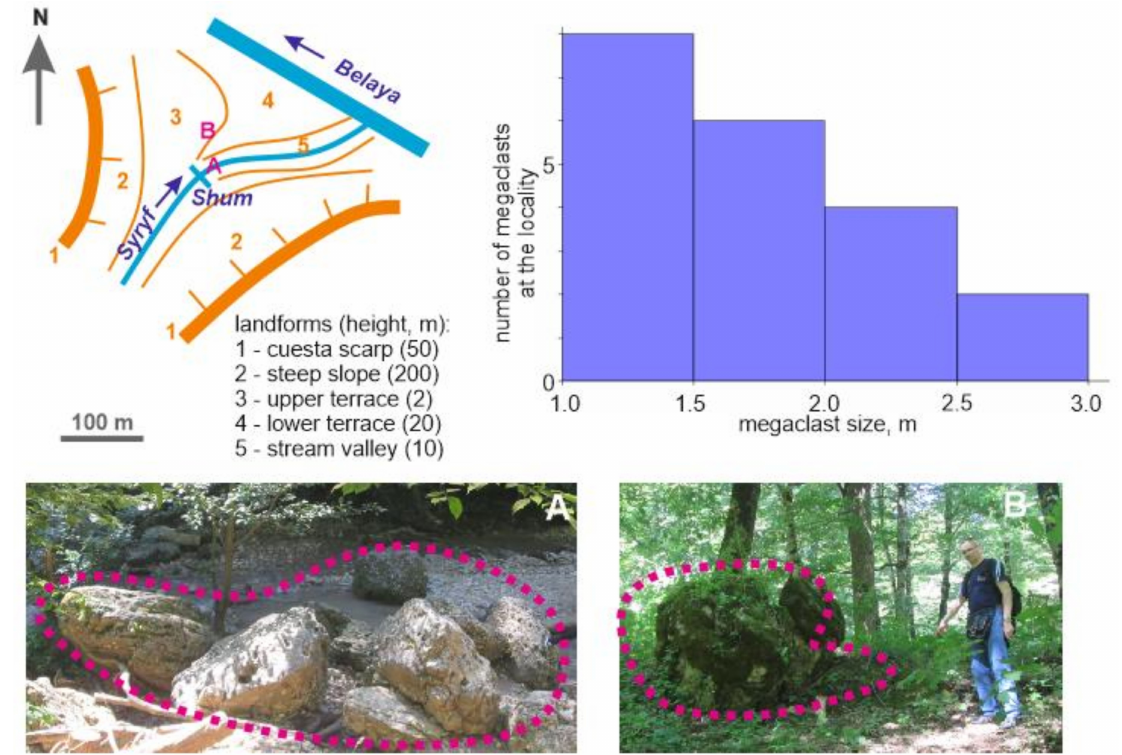
Figure 4. Megaclasts at the Shum locality: A —canyon bottom, B —upper terrace (see Figures 2 and 3 for location). Photos by